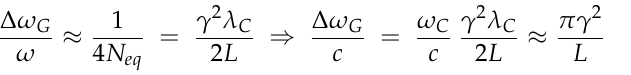
Figure 4. Electron bunch and radiation pulse interaction: ( a ) phase locking; and ( b ) electrons and radiation electric field interaction.